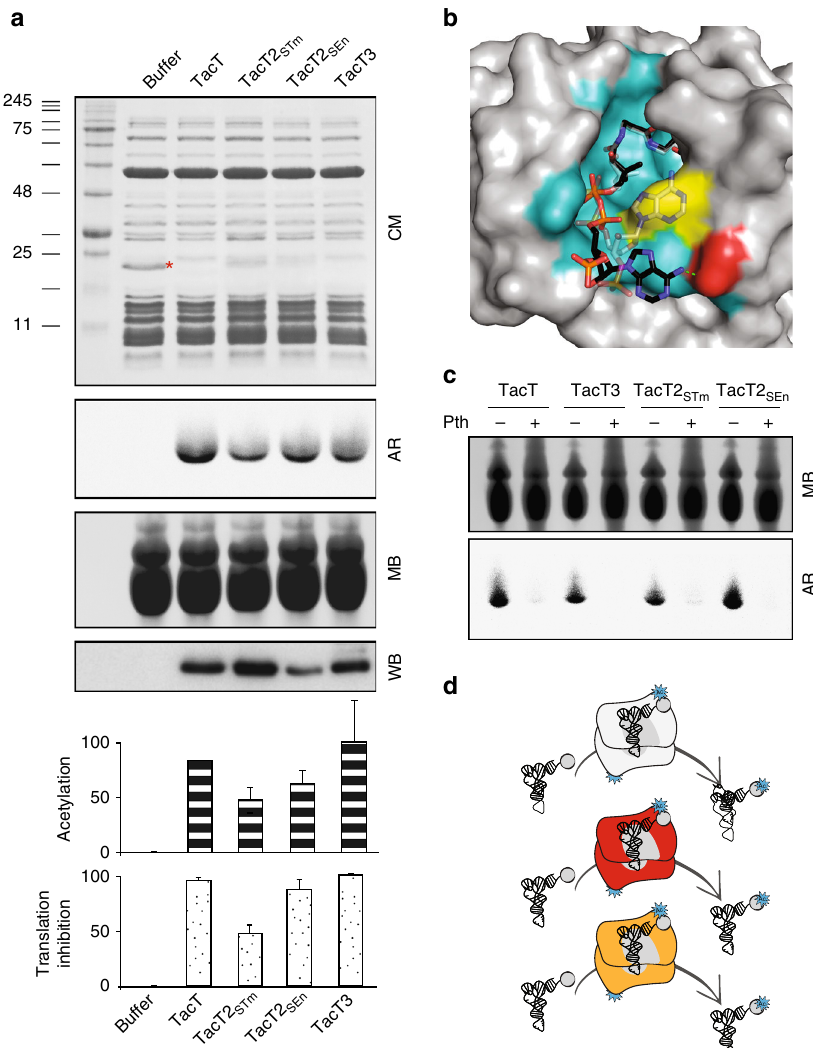
Fig. 3 Tac toxins block translation through acetylation of aminoacyl-tRNAs. a Cell-free expression assays leading to the production of the control protein DHFR (red asterisk) from template DNA without toxins or with puri fi ed TacT, TacT2 STm , TacT2 SEn or TacT3, added from the onset of the assay. [ 14 C]Ac- CoA was added to all the samples. All samples were analysed by SDS-PAGE, and the production of DHFR was revealed by Coomassie staining (CM). tRNAs extracted from the samples were analysed by acid-urea PAGE and revealed by methylene blue staining (MB) and acetylation tracked by autoradiography (AR). Equivalent amount of toxins added to the sample was tested by western blotting against His tag of the toxins (WB). Quanti fi cation of inhibition of the production of DHFR (spotted bars) and acetylation of tRNAs (dashed bars) in all conditions is reported in the bar charts, where data represent the mean ± SEM ( n ≥ 3). b Surface of the Ac-CoA-binding site of TacT3 with Ac-CoA represented as solid sticks for the orientation in TacT3 and shadowed for the orientation of Ac-CoA in TacT. Trp142 is in yellow and Gly145 is in red. c Exposure of tRNA molecules acetylated by TacTs to Pth treatment in vitro. tRNA molecules acetylated by different TacTs in vitro were subsequently incubated with puri fi ed Pth, acetylation was assessed by autoradiography, before or after samples were treated with puri fi ed Pth. All the samples were supplemented with [ 14 C]Ac-CoA. Treated tRNA molecules were separated on acid-urea polyacrylamide gel and revealed by methylene blue staining (MB) (top panel). Acetylation was tracked by autoradiography (AR) (lower panel). d Model of activity of Tac